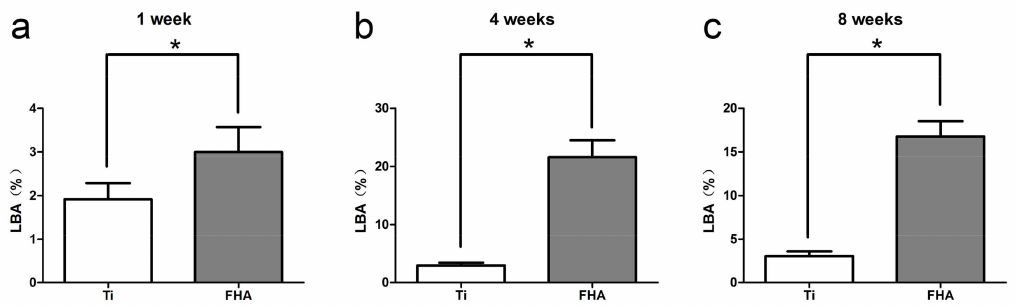
Figure 13. Fluorescently labeled bone area (LBA) after ( a ) 1 week, ( b ) 4 weeks, and ( c ) 8 weeks. * p <